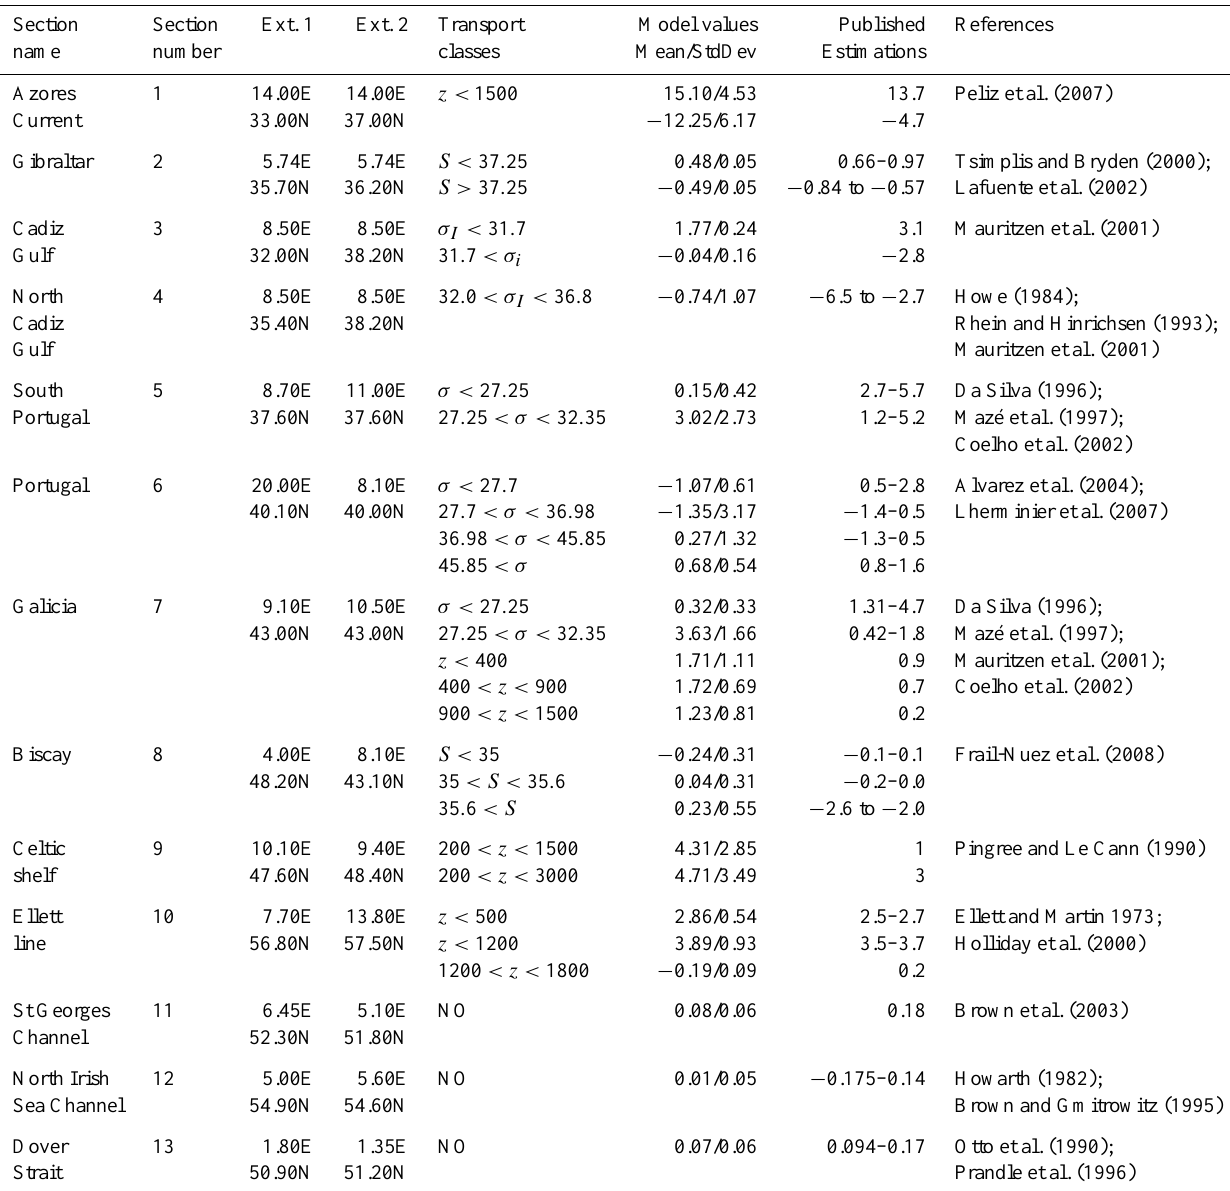
Table 3. Transport estimates from the model and the literature. Model transports are estimated from monthly fields and mean and standard deviation values are presented. Units are in Sv. Values in green (red) indicate net northward transports (net southward transports) for merid- ional sections or net eastward transports (net westward transports) for zonal sections as computed from observations. Values in black indicate net transports. Transport classes are defined using temperature classes ( T ), salinity classes ( S ) density classes ( σ ), depth classes ( z ) or with no classes (NO).